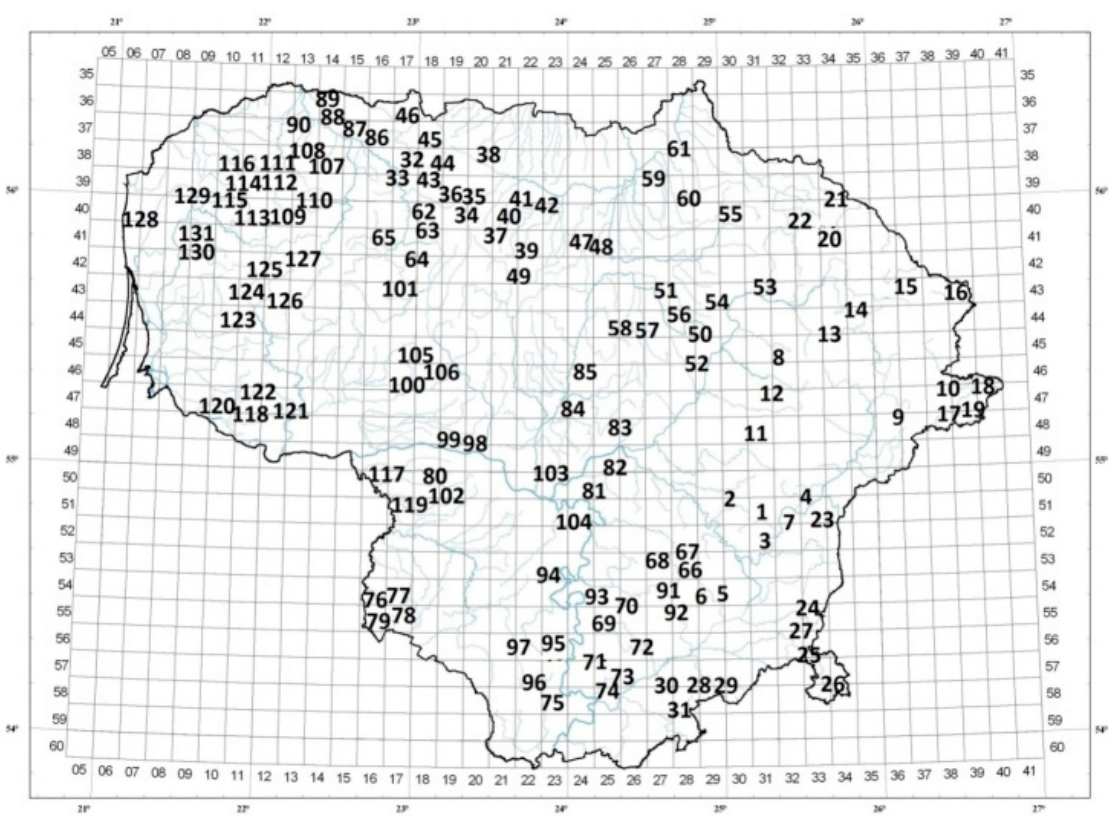
Figure 1. Distribution of investigated Thymus pulegioides habitats in Lithuania. Numbers of habitats of climatic sub-district: Aukštaitija: 1–4, 7–23; Dz¯ukija: 5, 6, 24–31, 66–75; M¯uša-Nev˙ežis: 32–65, 83–85, 101, 105, 106; the Nemunas Lowland: 80–82, 91–100, 102–104, 117–122; S¯uduva: 76–79; Venta: 86–90; Žemaiˇciai: 107–116, 123–127, 129, 130; Paj¯uris: 128; Paj¯uris Lowland: 131. Four clusters of T. pulegioides habitats were distinguished by cluster analysis accord- ing to percentage of above-mentioned main compounds of chemotypes of T. pulegioides and their precursors (Figure 2). Cluster 1 (cid:48) (34 habitats) distinguished habitats with the highest percentages of geraniol and biogenetically related compounds (geranial, nerol and neral). Geraniol in the habitats of this cluster was 6–8 times, geranial—4–10 times, nerol—4–13 times and neral—4–15 times higher than in the habitats of other three clus- ters (Table 2, Figure 2). There variation of geraniol, geranial, nerol and neral percentages between habitats was less in cluster 1 (cid:48) than in other clusters (Table 2). Tukey’s post-hoc demonstrated that cluster 1 (cid:48) significantly ( p < 0.05) differed from other clusters by the amounts of geraniol, geranial, nerol and neral. The highest geraniol percentage was found in habitat no. 69 (Kruonis) belonging to Dz¯ukija climatic sub-district (Figures 1 and 2. Thy- mol dominated in the essential oils of T. pulegioides samples collected in habitats of cluster 2 (cid:48) . Amounts of thymol in essential oils of T. pulegioides were 4–7 times higher in habitats of this cluster in comparison with other clusters. The variation of thymol and thymol methyl ether between habitats of this cluster was the lowest (Table 2). The highest amount of thymol was in habitat no. 128 (Palanga, Paj¯uris climatic sub-district) (Figures 1 and 3). Tukey’s post-hoc showed significant differences between cluster 2 (cid:48) and other clusters according to percentage of thymol and thymol methyl ether ( p < 0.05). In cluster 2 (cid:48) merged only 17 habitats. Clusters 3 (cid:48) and 4 (cid:48) characterised by high amount of carvacrol. Tukey’s post-hoc showed that habitats of cluster 3 (cid:48) significantly ( p < 0.05) differed from other clusters by the amount of carvacrol and γ -terpinene in the essential oil of T. pulegioides . The highest amount of carvacrol